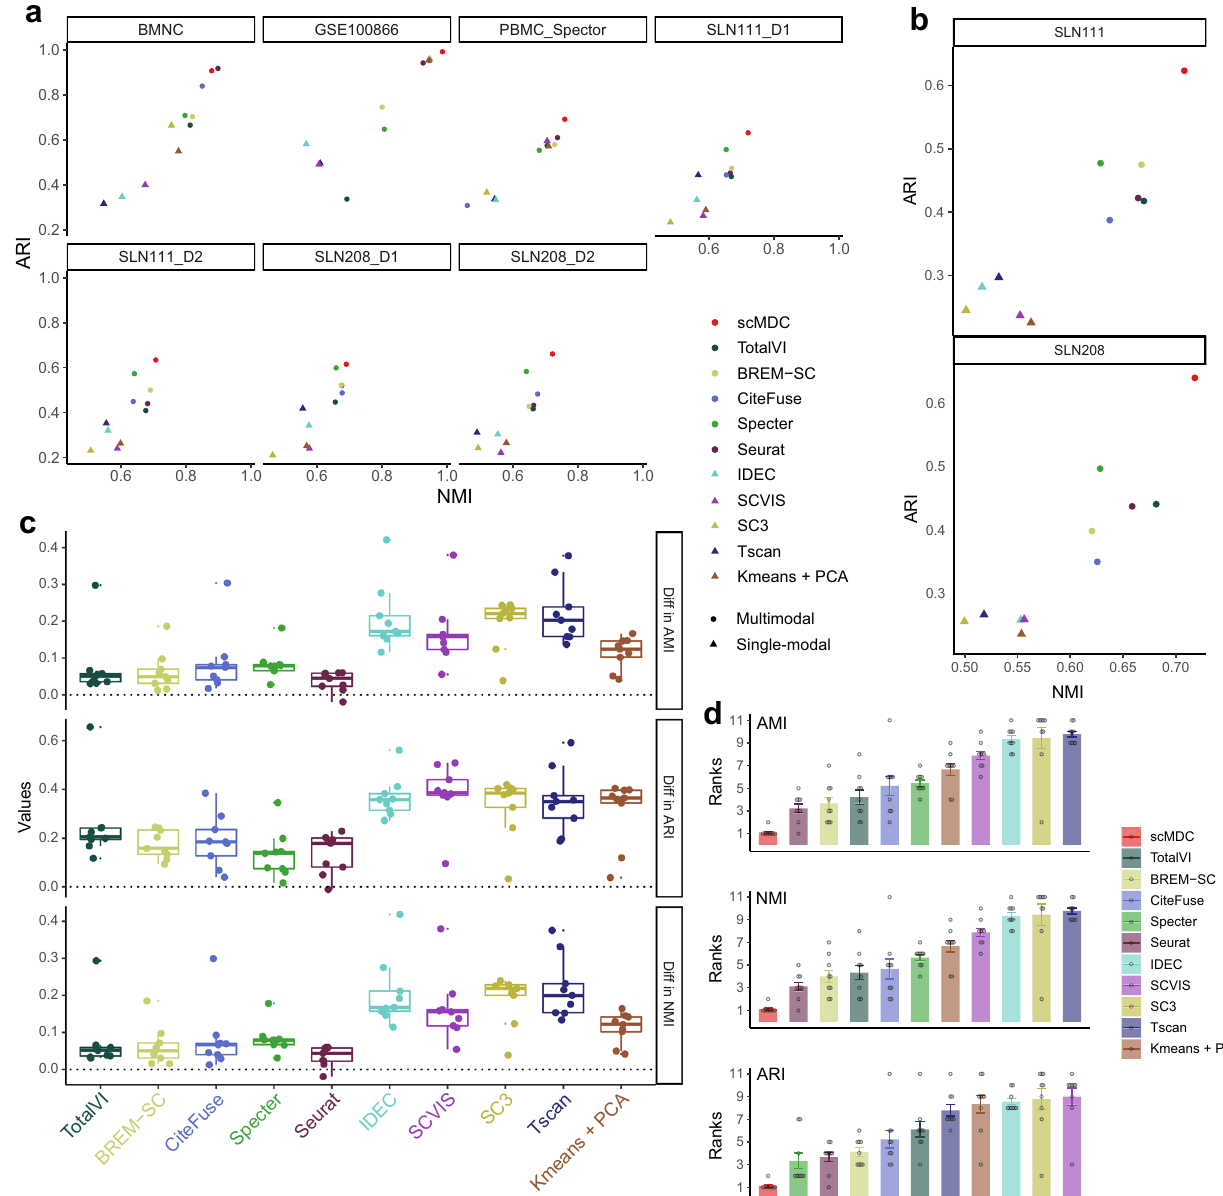
Fig. 2 | Clustering performance of scMDC and the competing methods on dif- ferent CITE-seq datasets. All the methods are tested on seven one-batch datasets ( a , n = 7) and two two-batch datasets ( b , n = 2). In panels ( a ) and ( b ), clustering performance is illustrated in a two-dimensional manner with ARI as the Y axis and NMI as the X axis. Circles stand for the results of the multi-omics methods and triangles stand for the results of the single-omics methods. The differences between the performance of scMDC and the competing methods are shown in boxplots ( c , n = 9). Each boxplot shows the minimum, fi rst quartile (Q1), median,